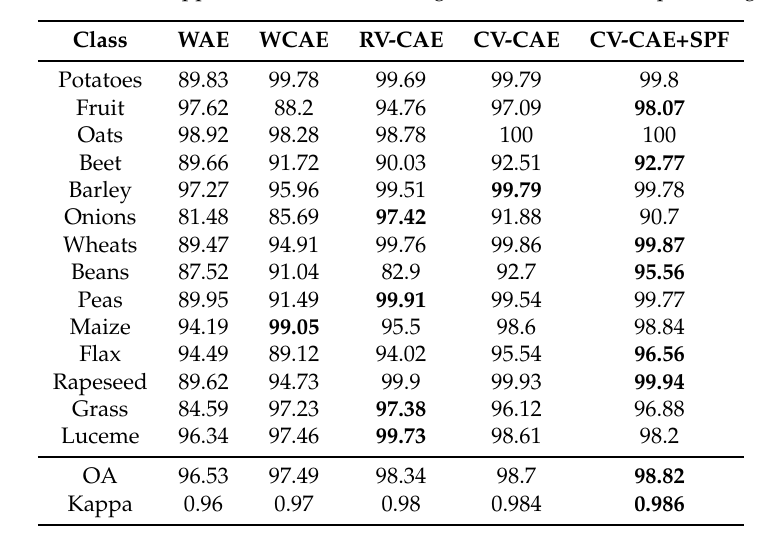
Figure 5. The classification results and the result overlaid with ground-truth of our algorithm and RV-CAE. ( a , d ) are result of CV-CAE. ( b , e ) are result of CV-CAE+SPF. ( c , f ) are result of RV-CAE. Table 3. The OA and Kappa Coefficient of Our Algorithms and the Compared